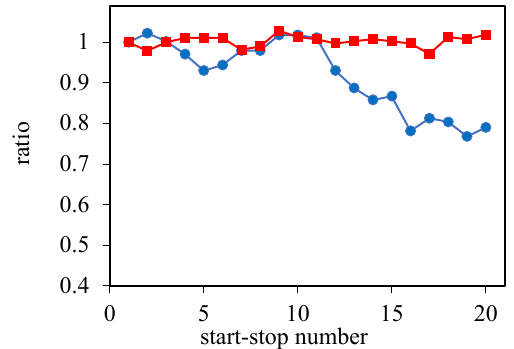
Figure 6. Ratio between the voltage after a given start–stop to the voltage after the first start–stop vs. the number of passed start–stop cycles at 0.8 A cm − 2 for two MEAs with different cathodes: the Celtec®P1000 cathode (circles) and CNF cathode (squares). Thus, the stability of the reinforced membrane PBI-O-PhT/es- m -PBI net and CNF elec- trode, as well as the degradation of the Celtec®P1000 electrode after the stress test, are